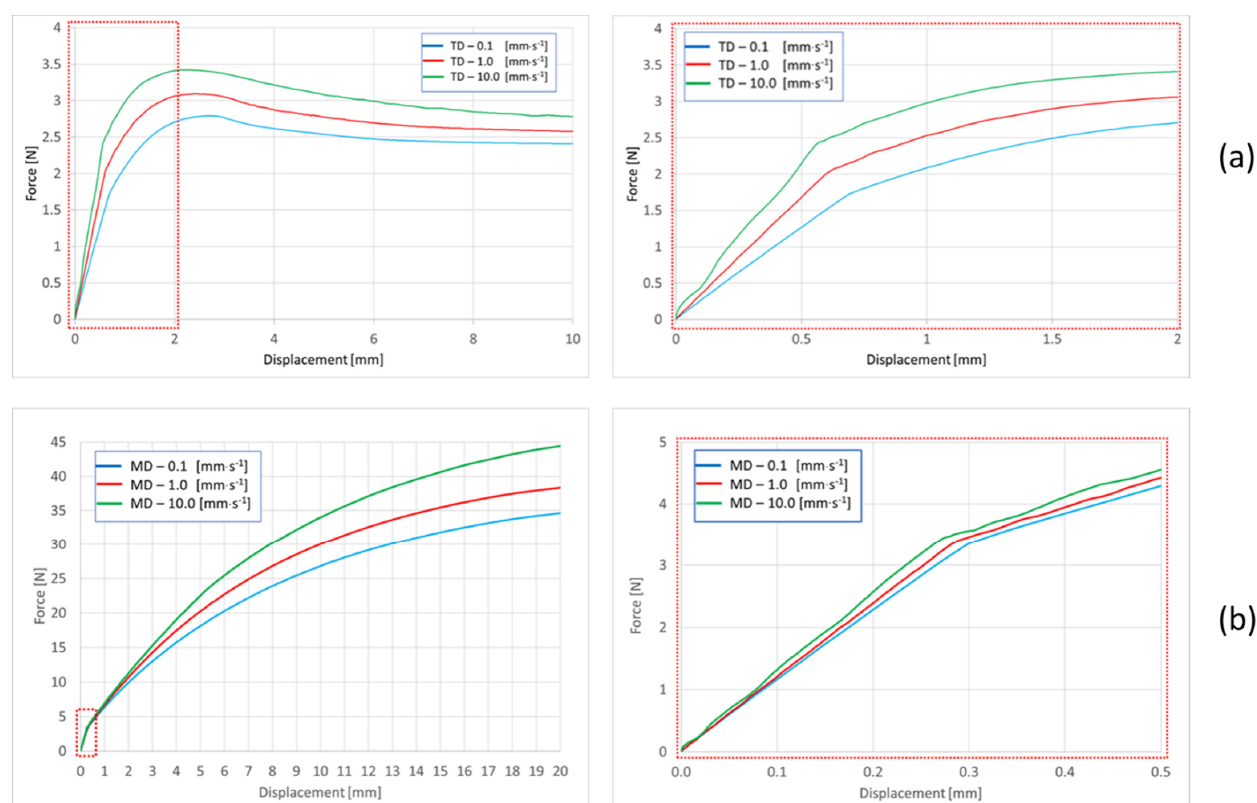
Figure 16. Force vs. displacement curves from simulations for different velocities. ( a ) load in TD, ( b ) load in MD.